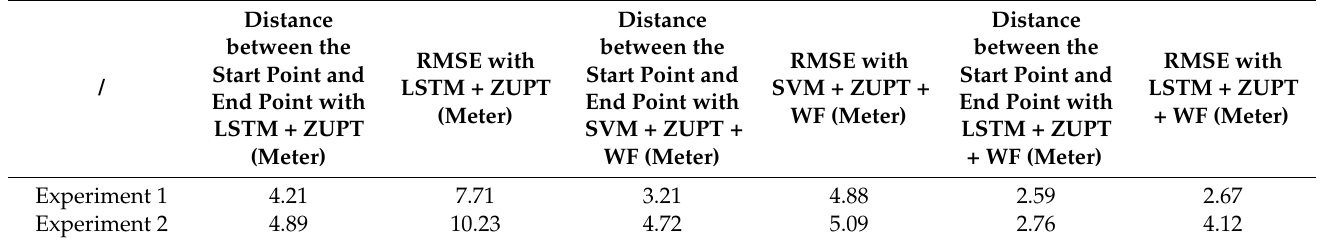
Table 5. Error comparison of positioning